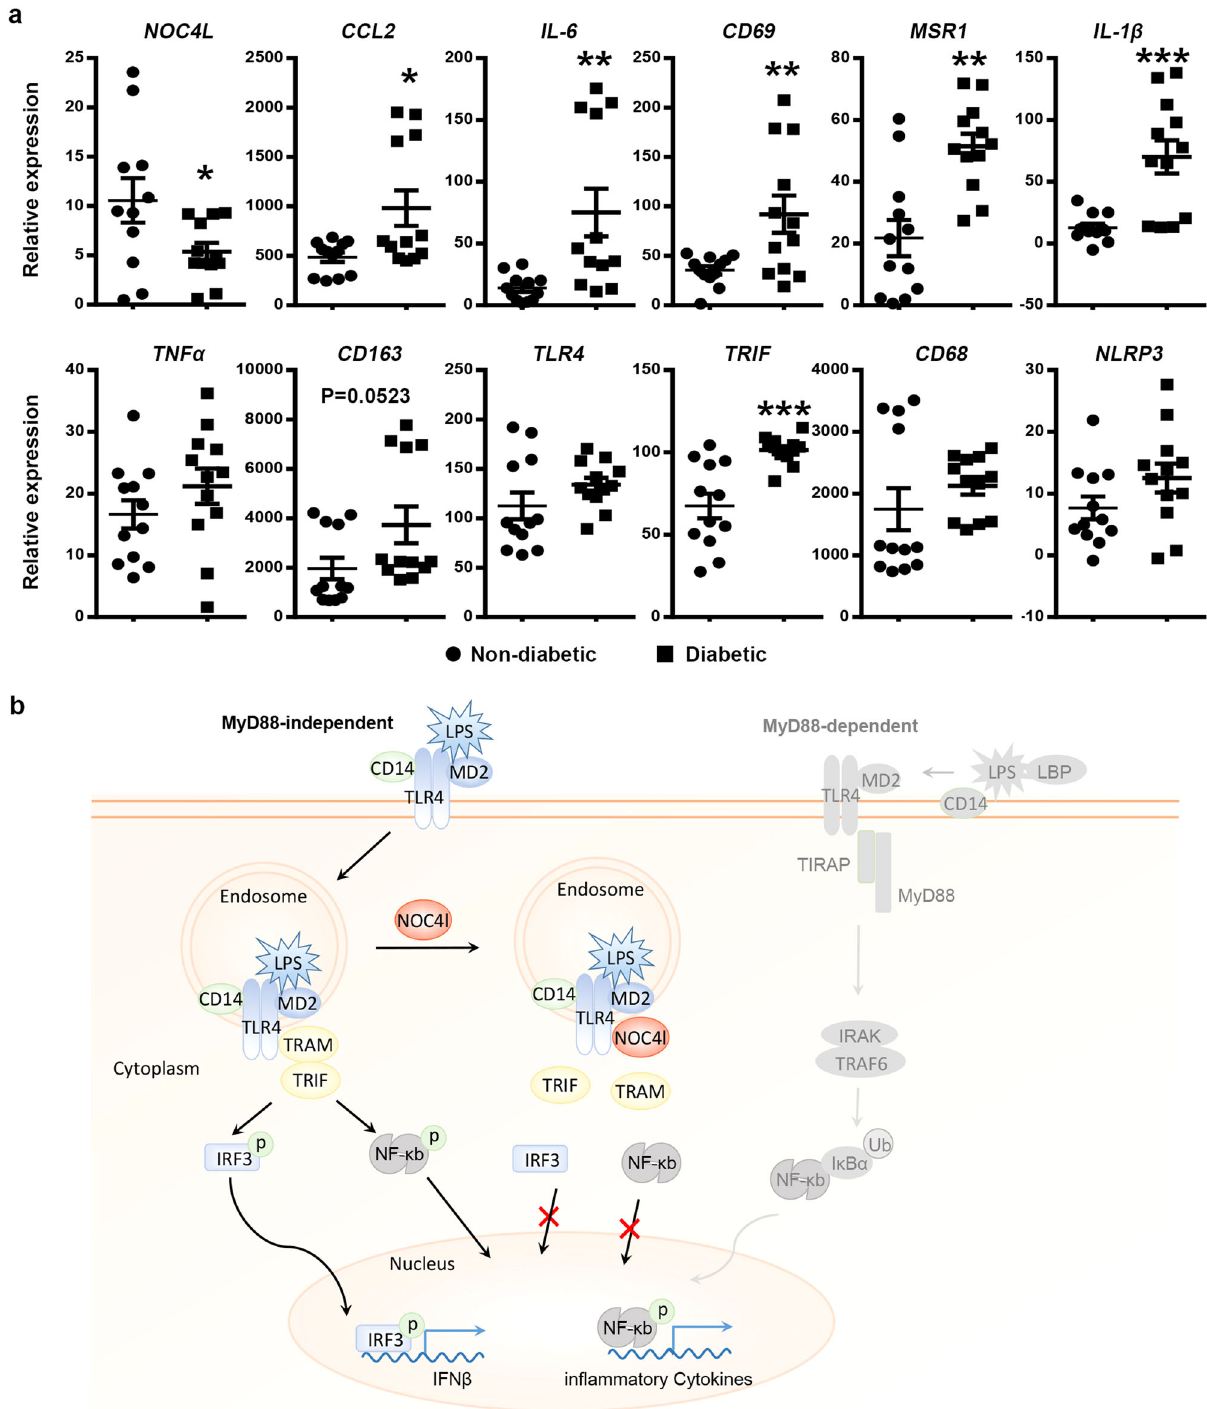
Fig. 7 Hypothetical working model of Noc4l and its clinical association with diabetes. a The mRNA expression levels of NOC4L and selected in fl ammatory genes, CCL2 , IL-6 , CD69 , MSR1 , IL-1 β , TNF α , CD163 , TLR4 , TRIF , CD68 and NLRP3 were determined in the visceral adipose tissues of patients with diabetes ( n = 12 per group) vs. non- diabetes ( n = 12 per group). All data are presented as mean ± SEM. Two-tailed Student ’ s t test. * p = 0.0381 ( NOC4L ), * p = 0.0146 ( CCL2 ), ** p = 0.0049 ( IL6 ), ** p = 0.008 ( CD69 ), ** p = 0.004 ( MSR1 ), *** p = 0.0004 ( IL-1 β ), *** p = 0.0004 ( TRIF ). * p < 0.05, ** p < 0.01, *** p < 0.001. b NOC4L was located in the early endosome of macrophages. It blocked the endocytosis of TLR4, thereby inhibiting TRIF signaling, reducing IFN β production, and reducing systemic in fl ammation. Source data are provided as a Source Data fi le.